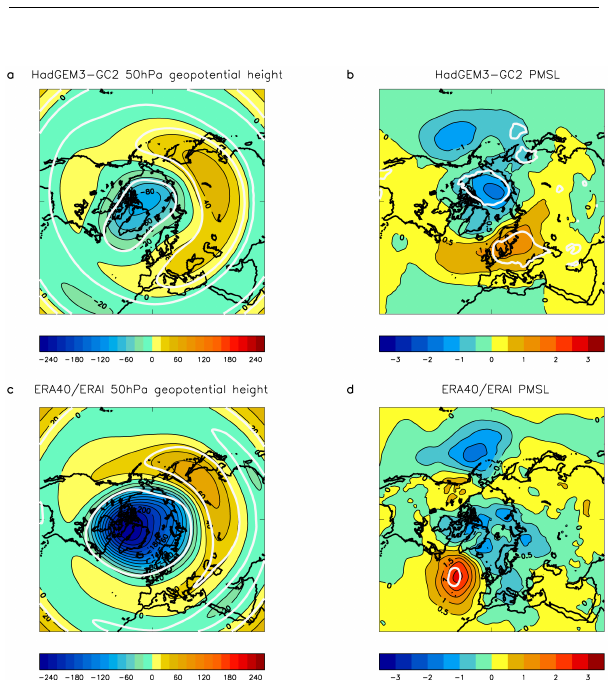
Figure 12. DJF composite mean 50hPa geopotential height and PMSL for westerly minus easterly QBO events (mean 50hPa equa- torial wind, using a threshold of ± 5ms − 1 ) in HadGEM3-GC2 CLIM experiment (a, b) and a combined data set of ERA40 (1957– 1978) and ERA-I (1979–2013) (c, d) . White contours show signifi- cance at the 90% level using a two-sided t -test.